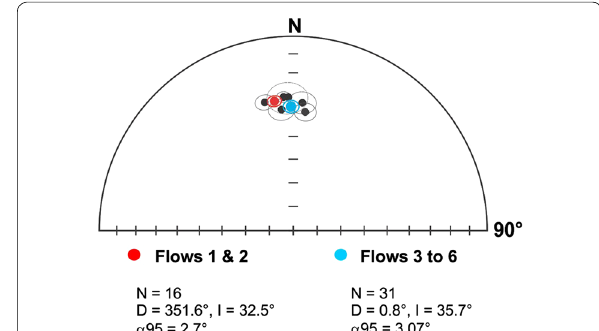
Fig. 8 Equal area projection showing the corresponding mean paleomagnetic directions for flows 1 and 2 (red dot), and for flows 3 to 6 (blue dot), together with their corresponding alpha_95